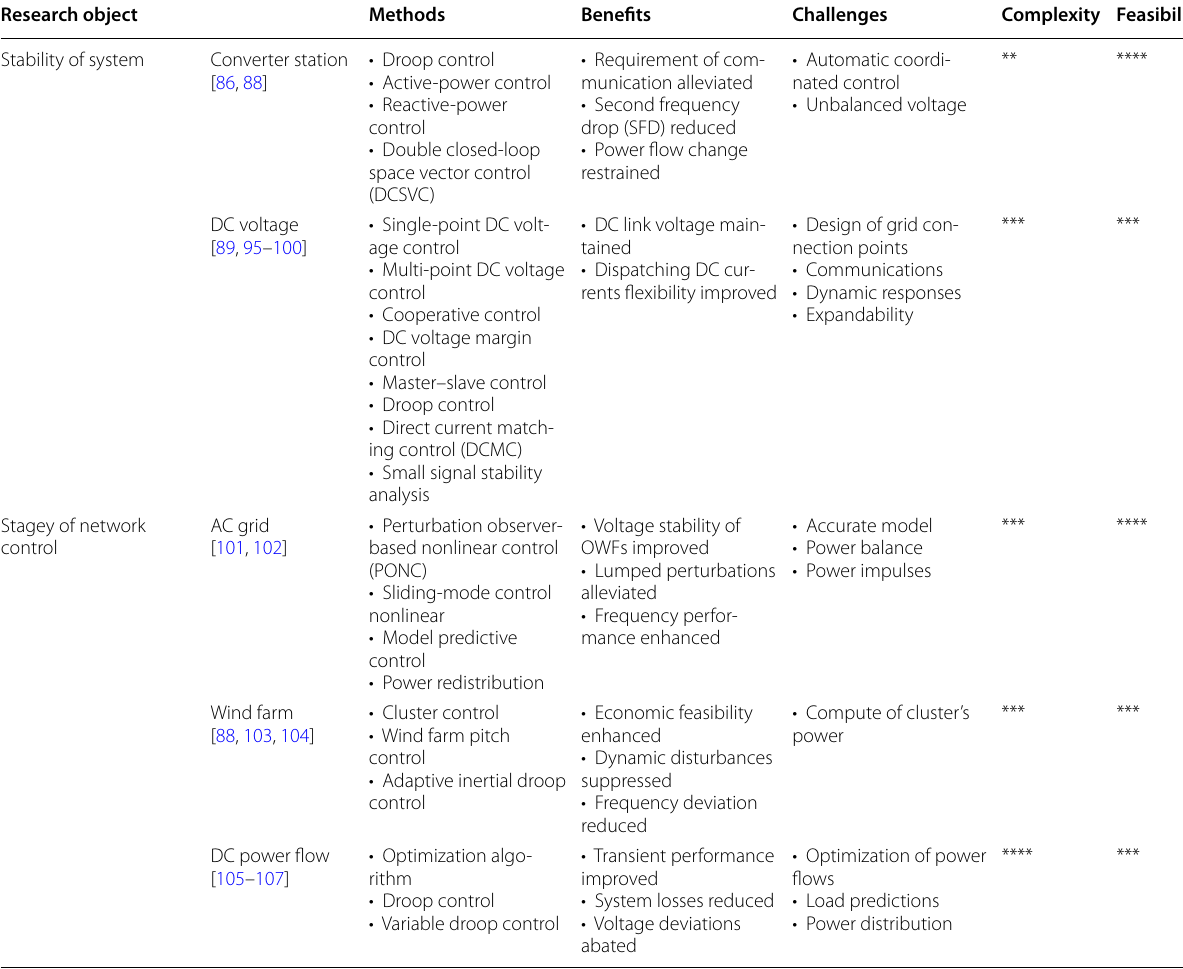
Table 4 Technologies of VSC-MTDC Research